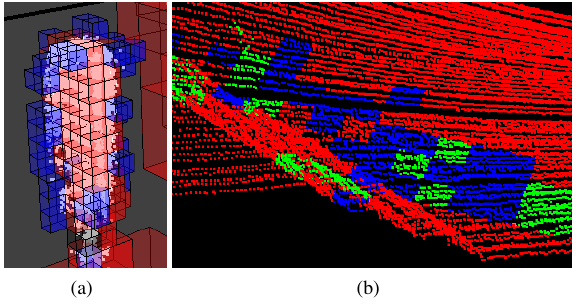
Figure 1. Traversal artifacts due to ray casting within discretized space. (a) Artifact caused at object borders. (b) Improper voxel classification near plane-like